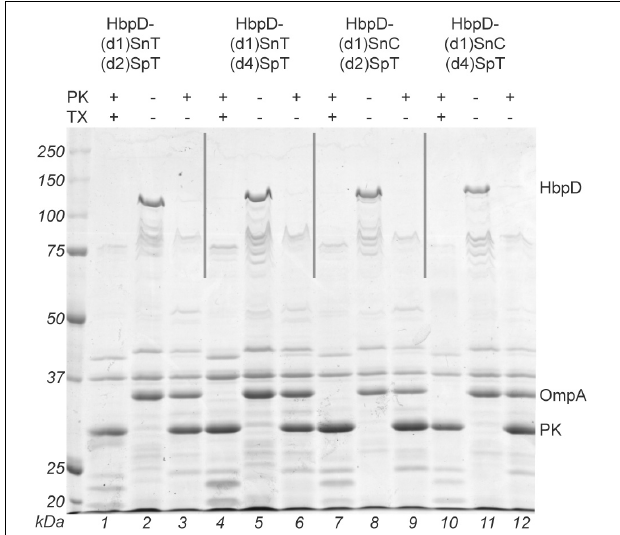
FIGURE 3 | Analysis of expression and surface exposure of HbpD containing both Spy and Snoop elements. OMVs, in the absence or presence of 1% Triton X-100 ( TX ), were incubated with proteinase K ( PK ). The samples were analyzed by SDS-PAGE and Coomassie staining. Full-length HbpD fusion proteins, OmpA, and proteinase K are indicated on the right side of the panel. Below the gel image lane numbers are